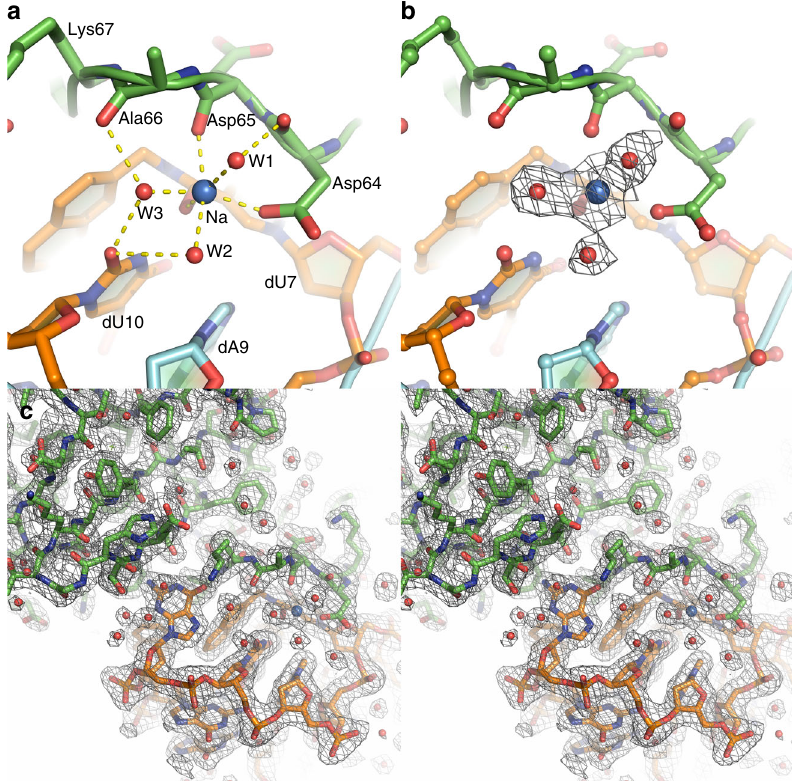
Fig. 5 The H-bond network along the IL-1 α /SL1067 binding interface is mediated by a Na + ion and three water molecules. a W1, W2, W3, OD1(Asp64), O (Asp65), and O21(2Nap-dU7) are coordinated by a sodium ion. Additional H-bonds are formed with the surrounding residues from either IL-1 α or SL1067: W1-O (Asp64), W2-O2 (2Nap-dU10), O(Ala66)-W3-O2(dU10). The lengths of these H-bonds are listed in Supplementary Tables 4 and 5. b The same view of the H-bond network as shown in a . 2Fo – Fc electron density for the Na + ion and surrounding water molecules is shown in gray mesh and contoured at 1 σ . c Wall-eyed stereo image of the IL-1 α /SL1067 crystal structure. Electron density from the fi nal 2Fo – Fc map contoured at 1.0 σ . SL1067 is colored orange and the protein is colored in green . Red spheres depict associated water